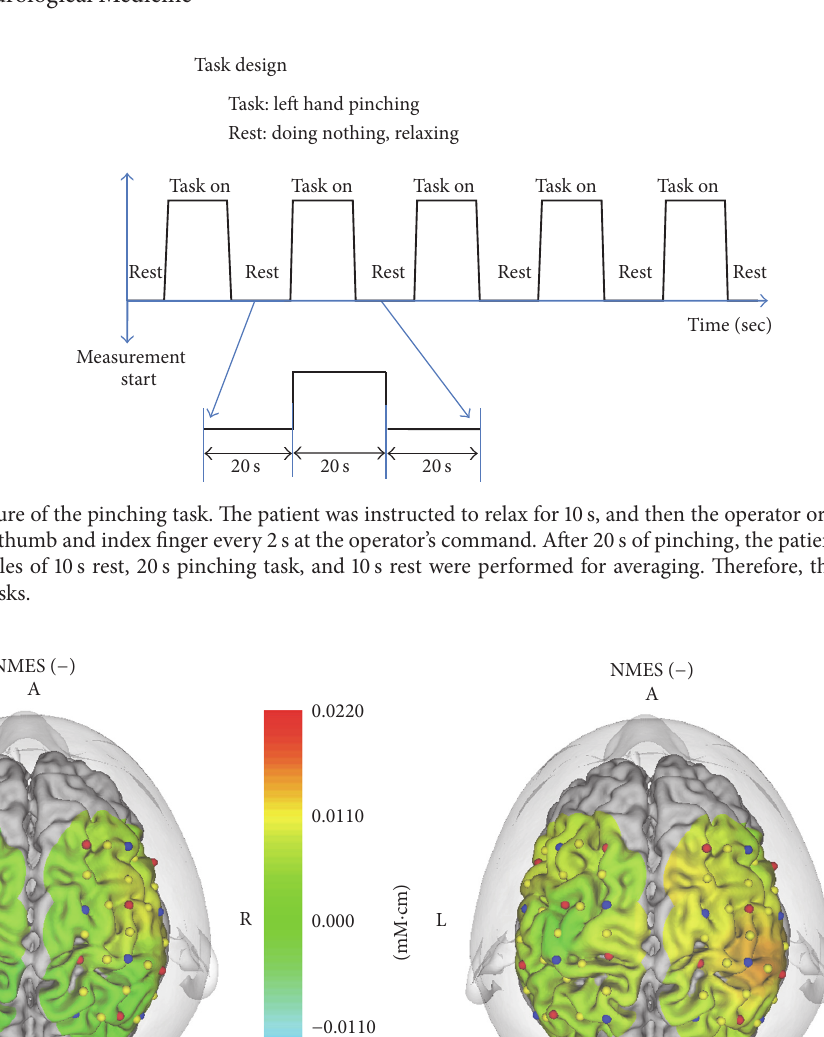
this sensory gate for motor control is lost in dystonia